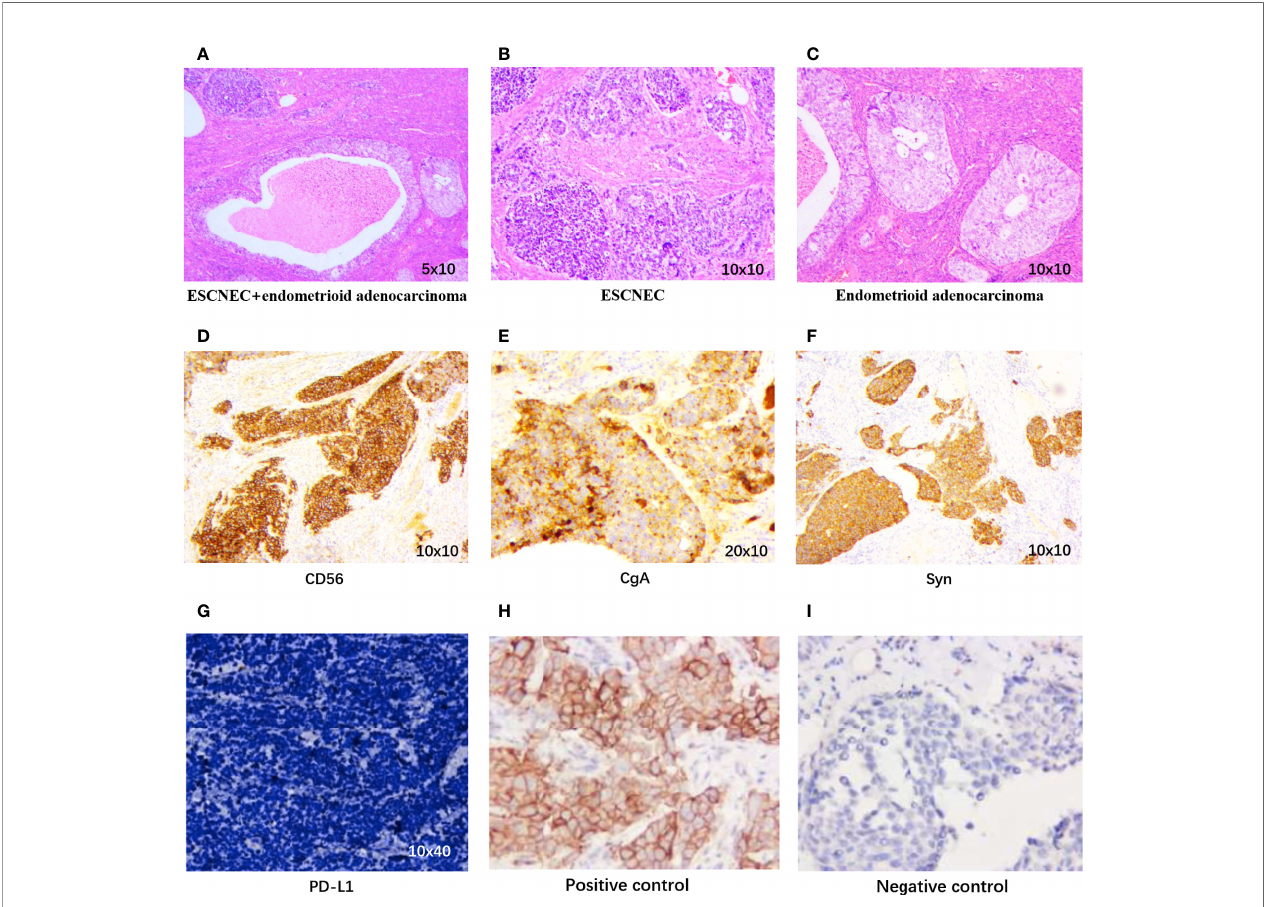
FIGURE 2 | Pathological fi ndings. (A) Coexistence of small cell neuroendocrine carcinoma (SCNEC) and endometrioid adenocarcinoma in the uterus (H&E, 5 × 10). (B) The SCNEC area shows small round cells in nests and clusters (H&E, 10 × 10). (C) Typical features of endometrioid adenocarcinoma (H&E, 10 × 10). Immunohistochemistry staining positive for (D) CD56 (10 × 10), (E) CgA (20 × 10), and (F) Syn (10 × 10). (G) PD-L1 expression of our case, (H) Positive control of PD-L1, (I) Negative control of